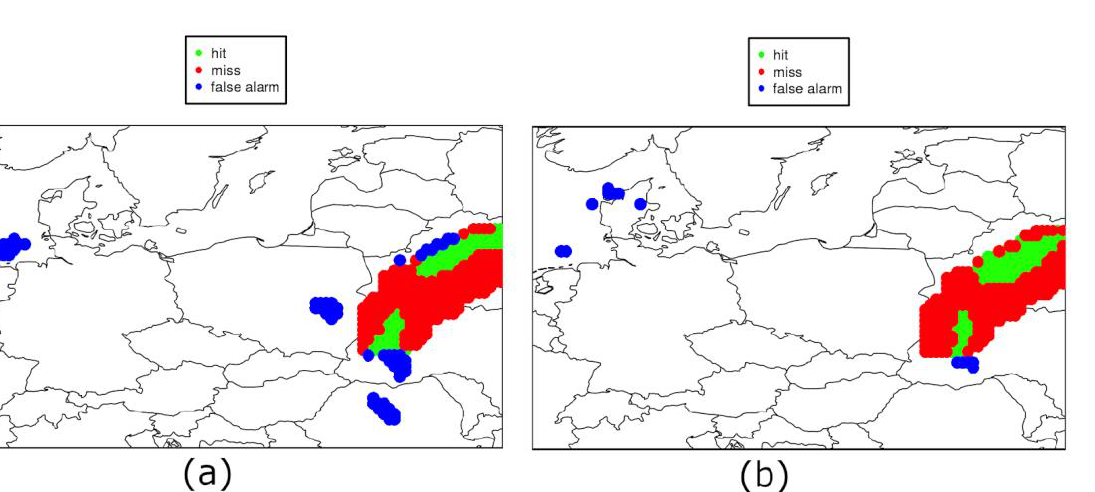
Figure 6. Results of the trained system with respect to removing the surface fields from the train- ing database.